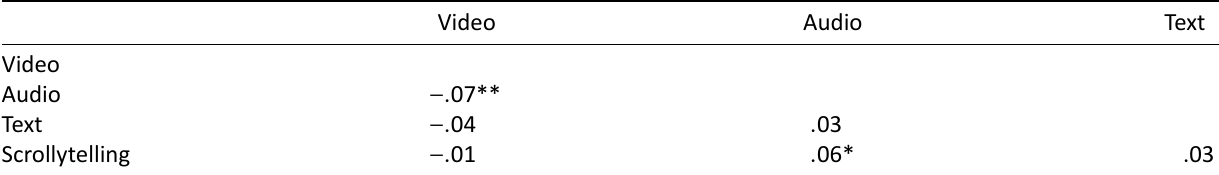
Table 3. Contrast analyses of information recall.